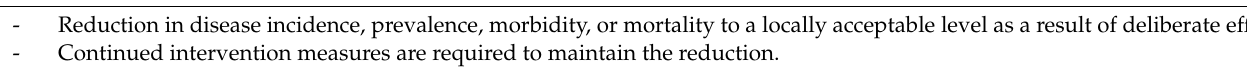
Table 1. Definition of control, elimination, and eradication of viral infection by WHO. Control of